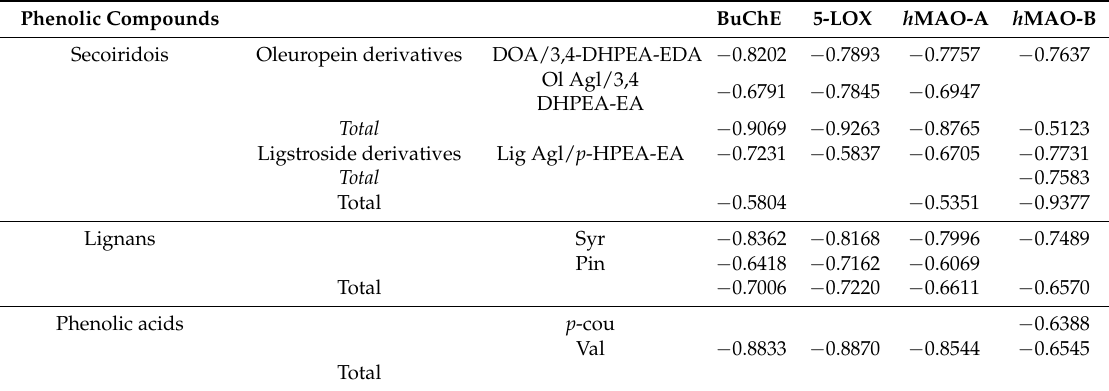
Table 2. Pearson correlation coefficients between the phenolic compounds in (cid:48) Brava (cid:48) , (cid:48) Mansa (cid:48) , (cid:48) Cornicabra (cid:48) and (cid:48) Picual (cid:48) olive oils (3 samples per oil and n = 12, p < 0.05) and the IC activities for BuChE, 5-LOX and h MAOs in the EVOOs. IC 25 inhibitory activity for AChE was not considered because of lack of data for (cid:48) Mansa (cid:48) and (cid:48) Picual (cid:48) ; the same was taken into account in Figures 3–5 with multivariate